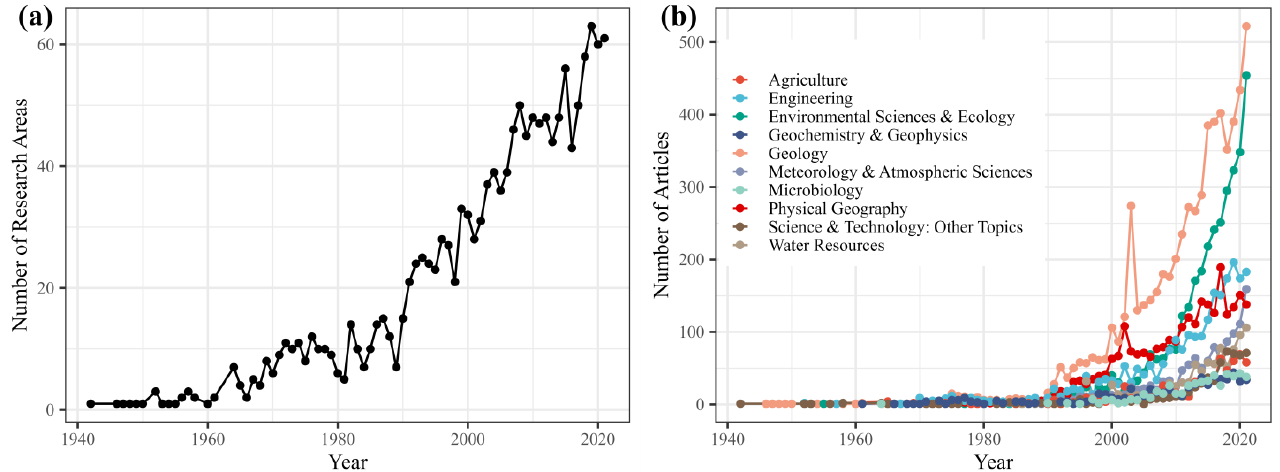
Figure 3. Features of WoS research areas for permafrost-related publications: ( a ) number of WoS research areas by year and ( b ) the temporal evolution of the top 15 most-productive WoS research areas.